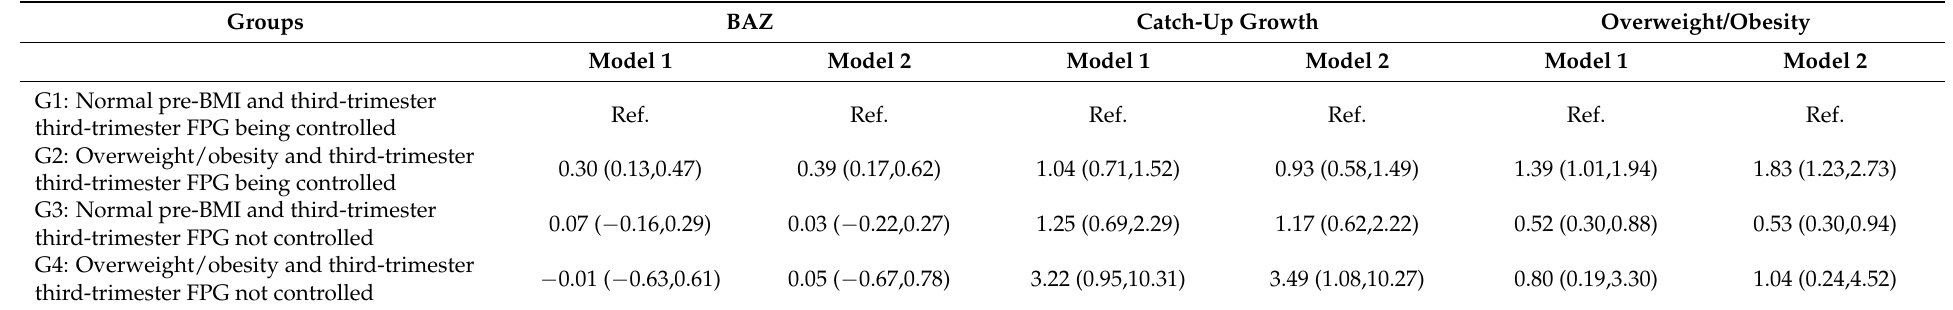
Table 3. The independent and combined effects ( β /RRs and 95% CI) of pre-pregnancy BMI and third-trimester FPG on offspring growth from 1 to 24 months in GDM-negative pregnant women by generalized estimation equation. ( n =